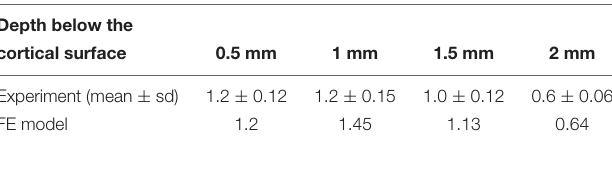
for Dummy Technology and Biomechanics, Germany) score